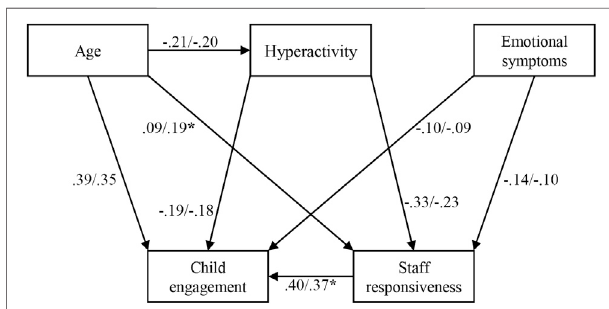
FIGURE2| Multi-groupchildengagementmodelspath.Note:Totheleft of the slash punctuation of each path is the path coef fi cient for L1-learners, and to the right is the path coef fi cient for L2-learners (L1-learners coef fi cient/ L2-learners coef fi cient). All paths were p < 0.01, except for the path Age > Staff responsiveness, which was p < 0.01 for both groups. *indicates that there was a signi fi cant path between the two groups.